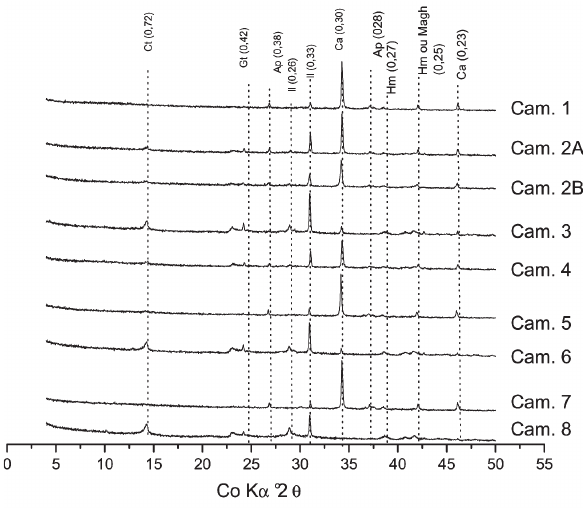
Figura 3. Difratogramas de raios-X da fração argila natural do solo da Lapa do Malhador. Il: illita; Ct: caulinita; Ca: calcita; Hm: hematita; Mh: maghemita; Gt: goethita; e Ap: apatita.